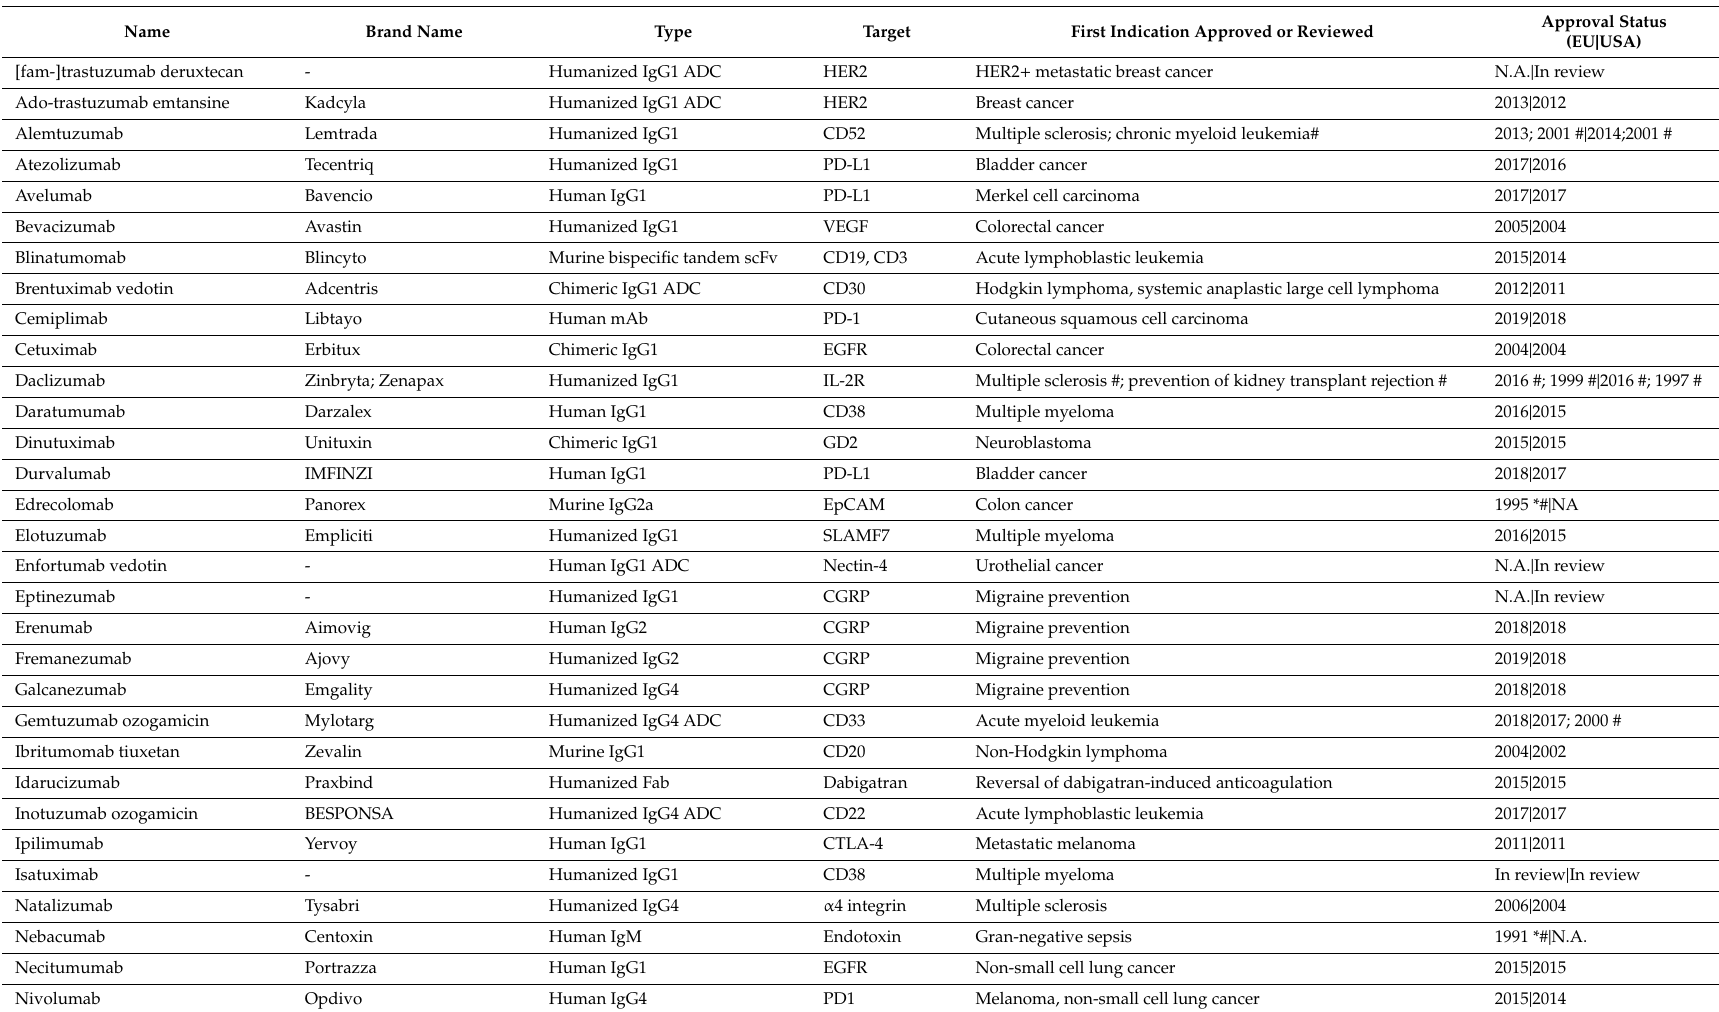
Table 1. Antibody therapeutics that are approved or in review for marketing for cancer or central-nervous-system (CNS)